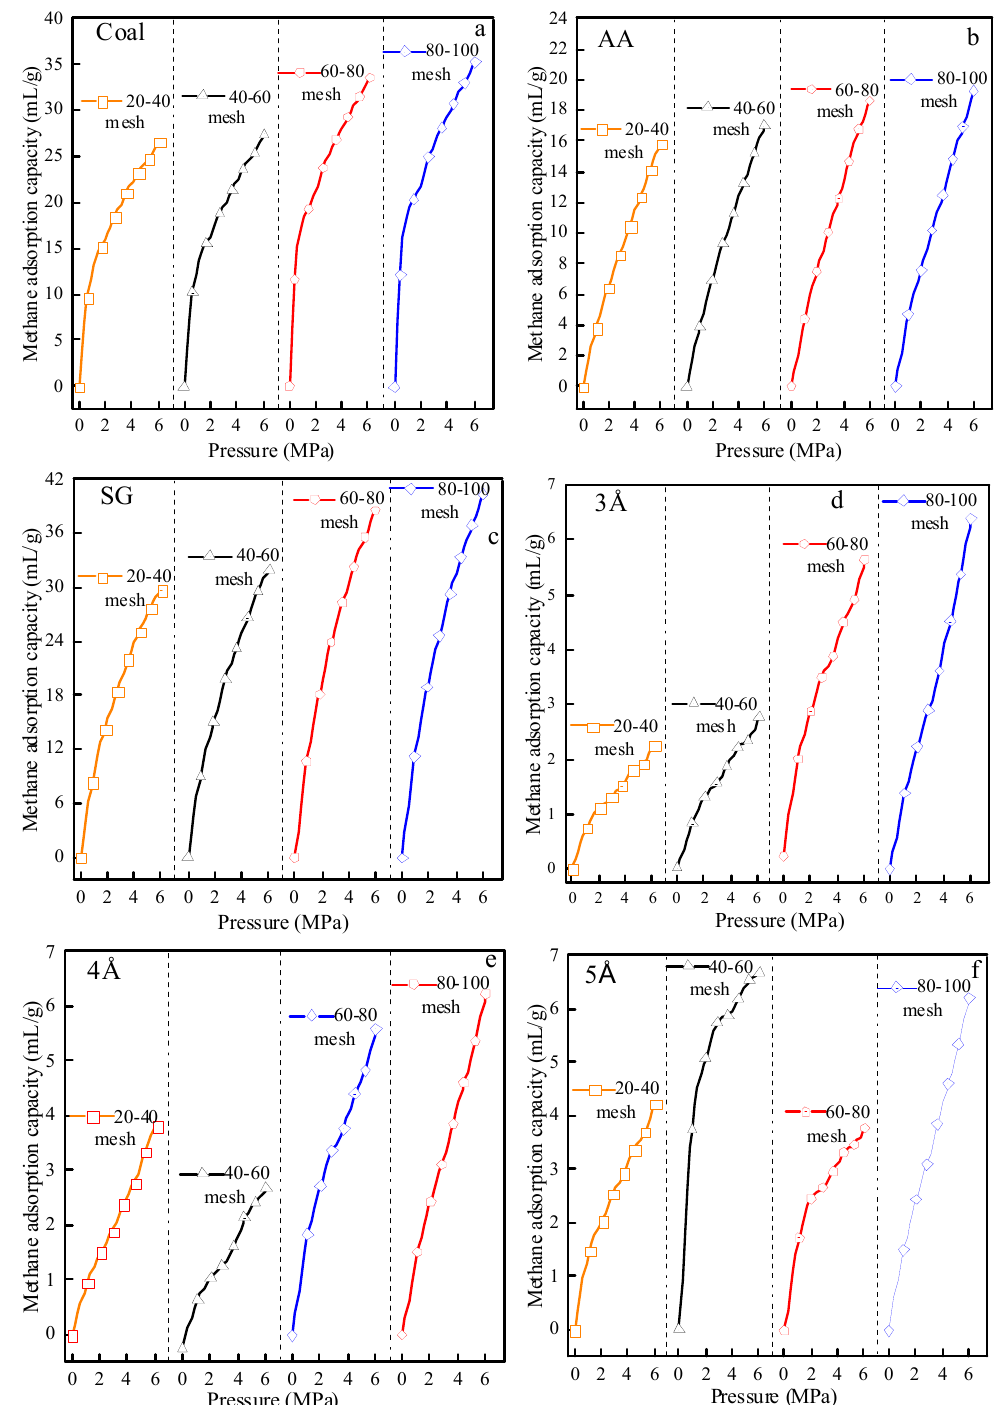
Figure 6. Methane adsorption capacity of testing materials in different particle size: ( a ) Aiweiergou 1890# working face coal sample; ( b ) Activated alumina; ( c ) Silica gel; ( d ) 3Å molecular sieve; ( e ) 4Å molecular sieve; ( f ) 5Å molecular sieve.